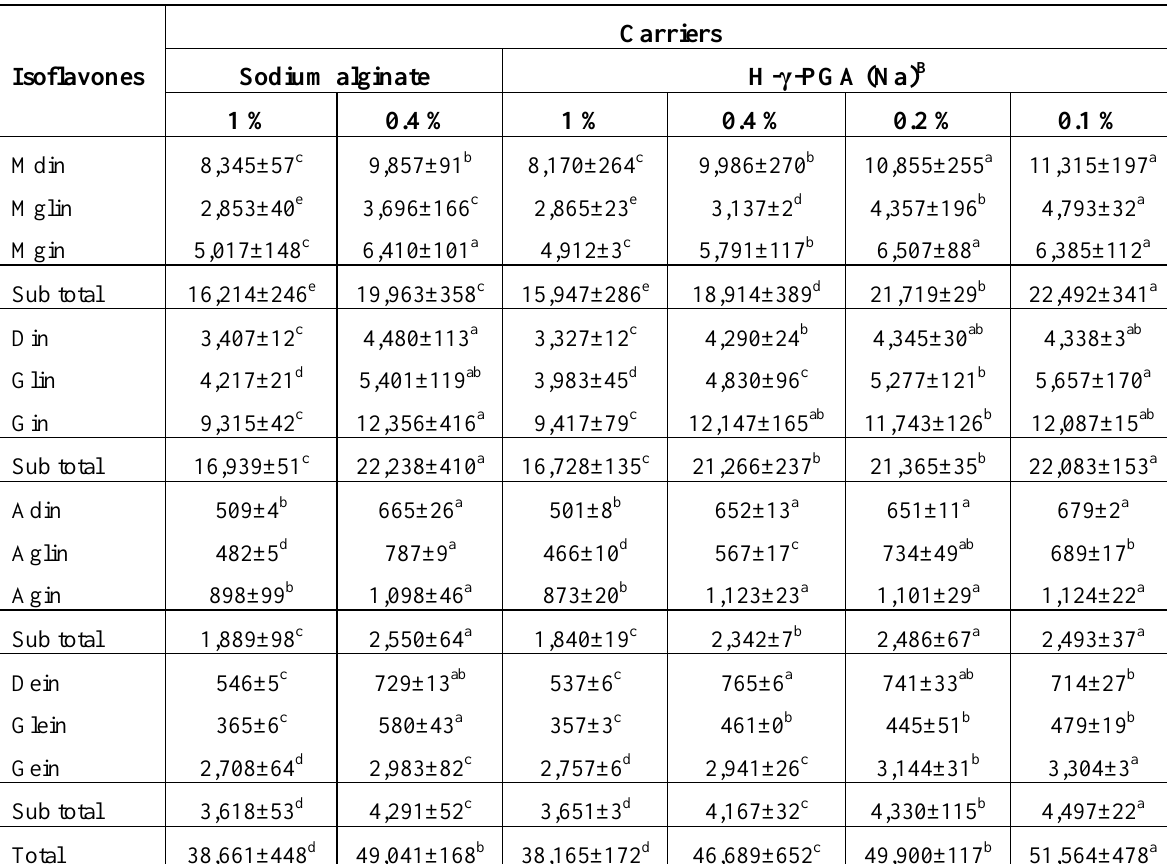
Table 2 . Isoflavone contents ( μ g/g) A in the vacuum-dried powder with sodium alginate and H- γ -PGA (Na) B as carrier C